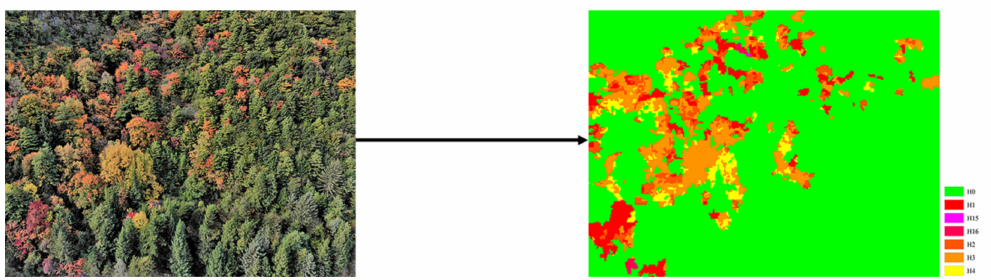
Figure 3. Diagram of color-leaved patches processing. The left is the original picture of a plot; the right is the map of color-leaved patch distribution after processing; H1—H4 and H14—H16 represent color-leaved patches and H0 represents green patches. H1 represents red color-leaved patches; H2 represents red-orange color-leaved patches; H3 represents orange color-leaved patches; H4 represents yellow color-leaved patches; H14 represents fuchsia color-leaved patches; H15 represents rose color-leaved patches; H16 represents magenta color-leaved